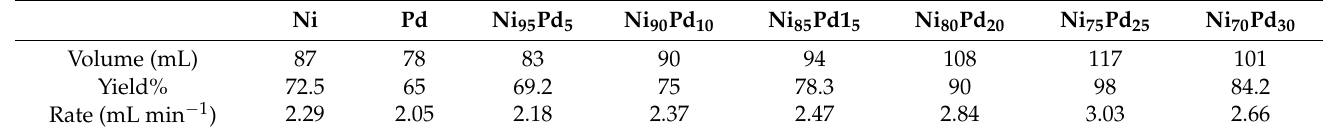
Table 1. H 2 evolved yields and rates by polymer membranes used different Ni/Pd ratios at 298 K.